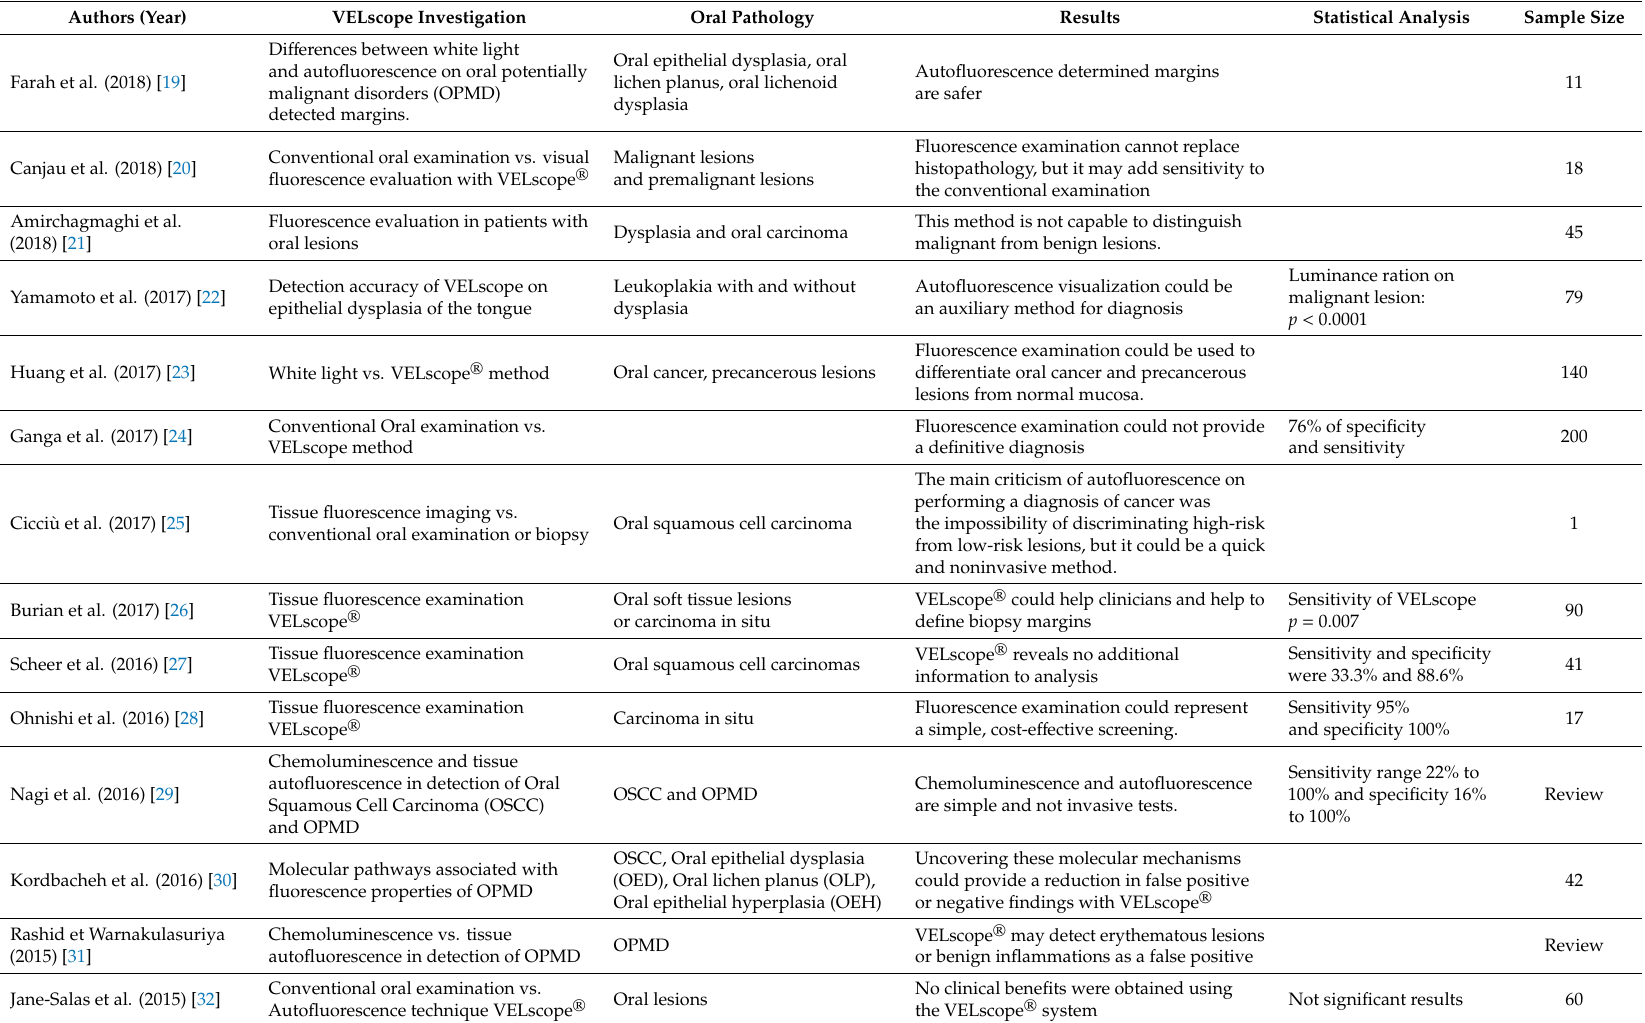
Table 1. Synthesis of